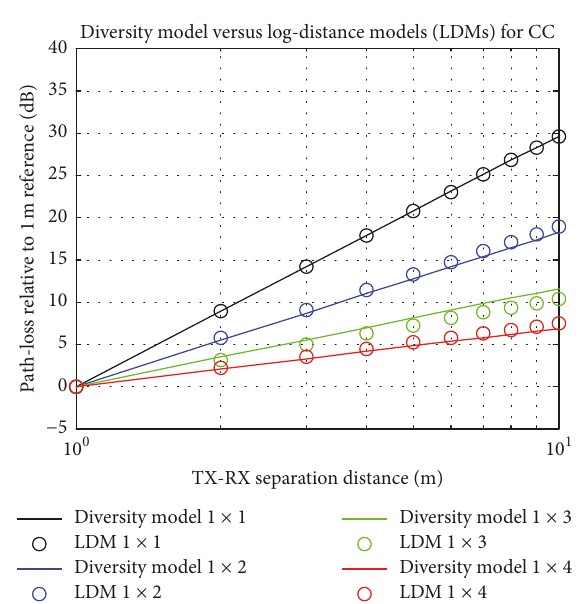
Figure 14: Path-loss for the proposed log-distance-based diversity model given by (5) for the CC scheme when considering NLOS scenario, with 𝑛 SISO = 2.959 and 𝐴 = 0.385 . Diversity model versus log-distance models (LDMs) for NCC